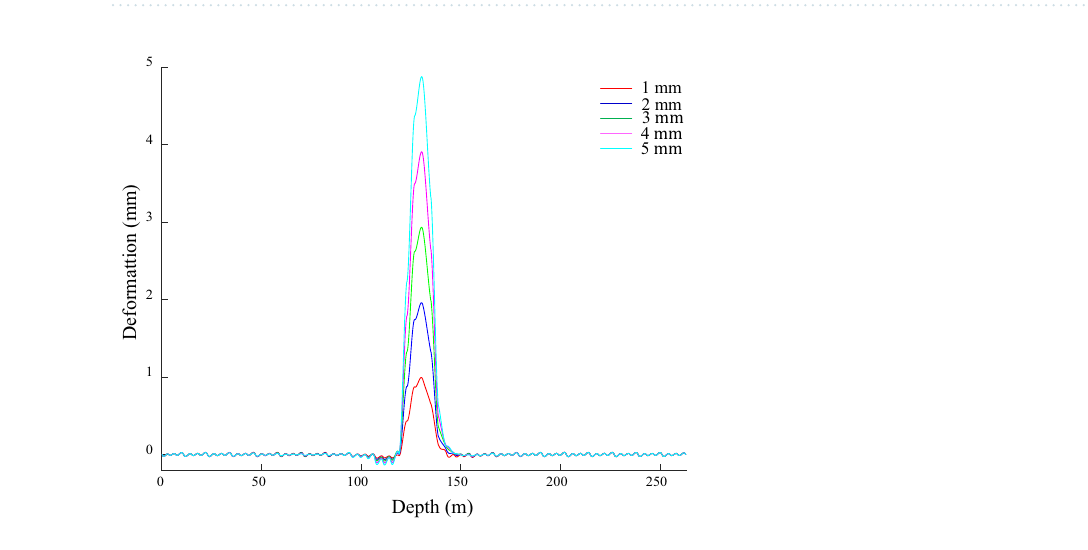
Figure 12. GRD in x -direction under